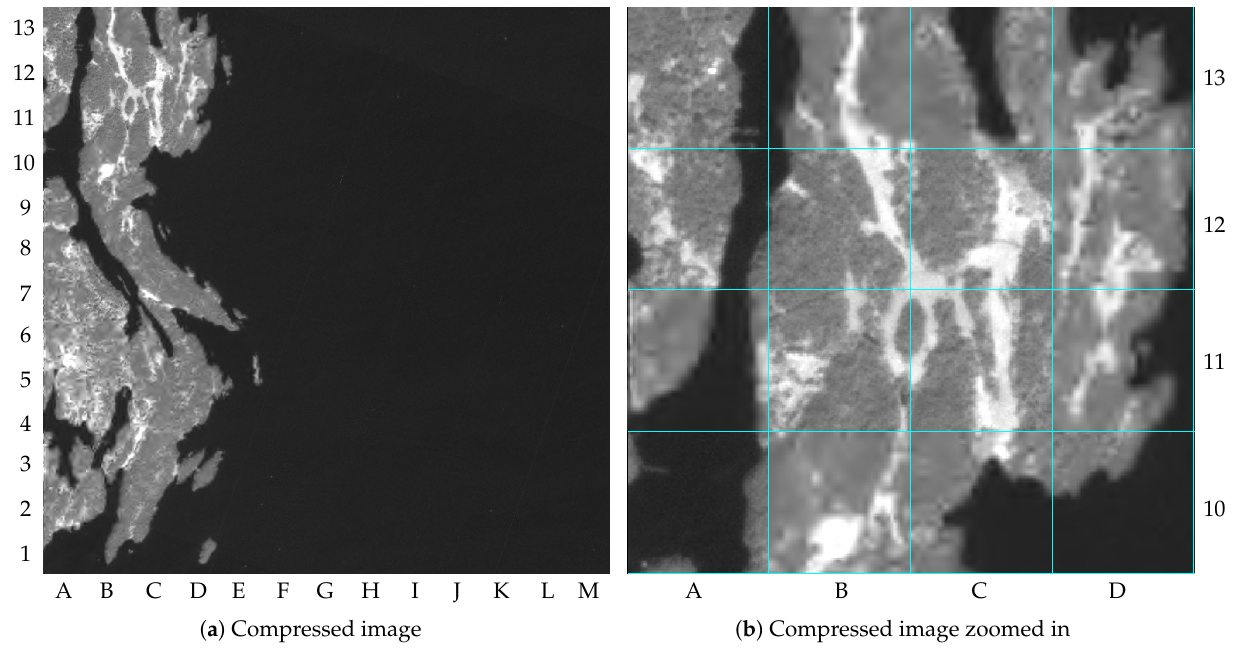
Figure 8. NIR band of the image 1 compressed with the proposed method (truncated at 4000): ( a ) compressed image; ( b ) compressed image zoomed